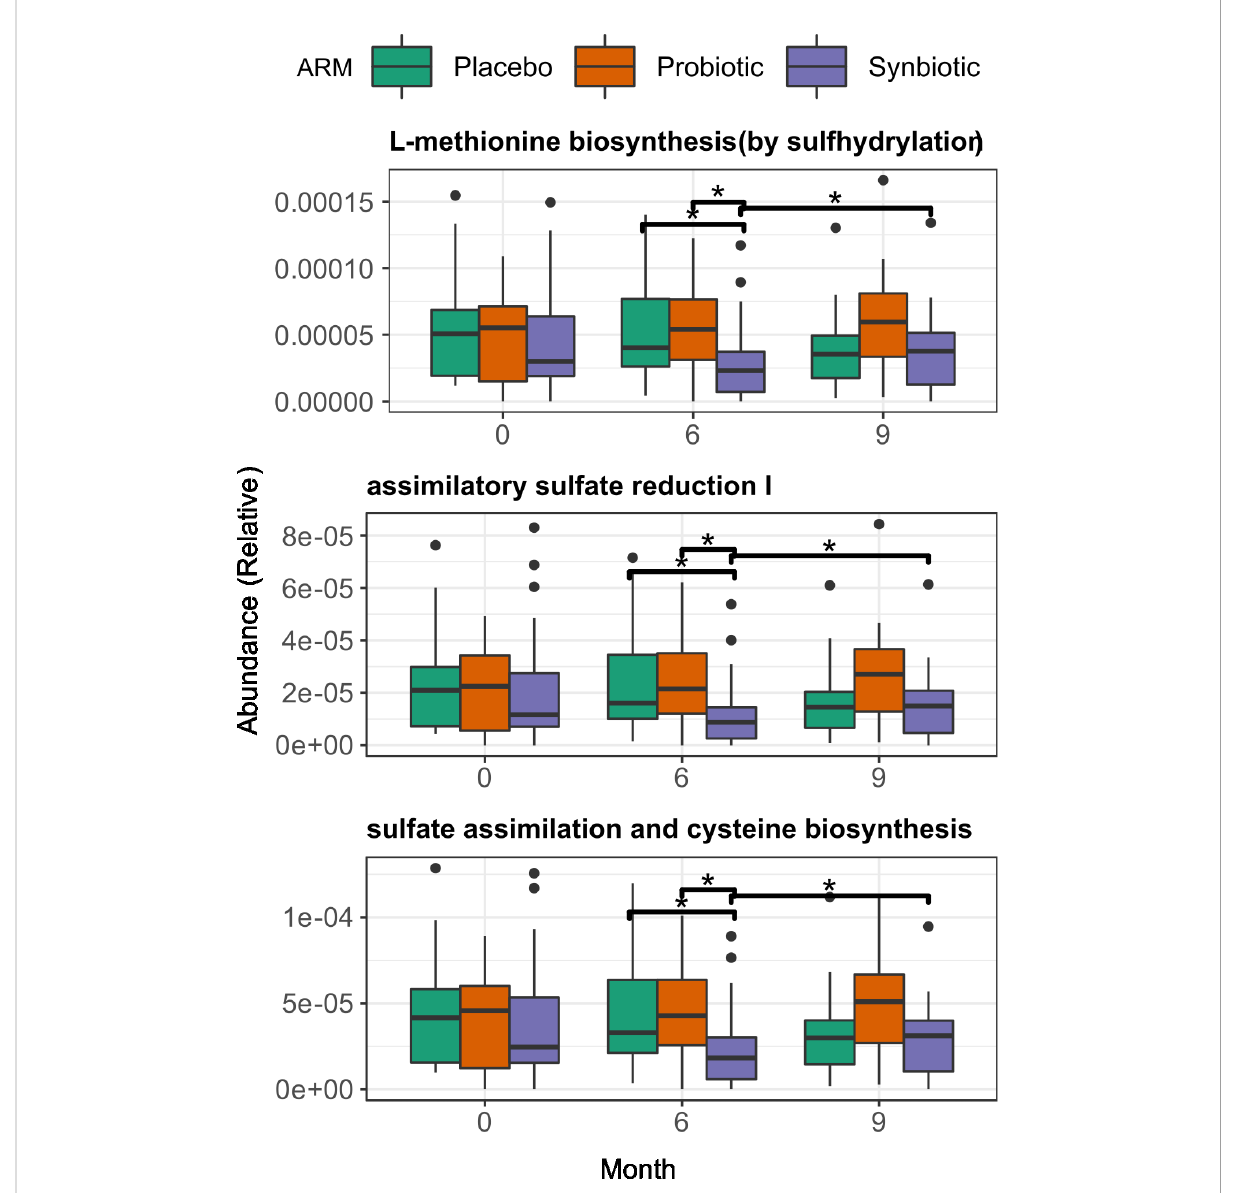
FIGURE 4 Changes in gene function at both start and end of the treatment period, among treatment group. Across group comparisons were performed with regular Wilcoxon test and longitudinal comparisons were performed using matched-samples Wilcoxon test. Signi fi cance was coded as follows: *(p <